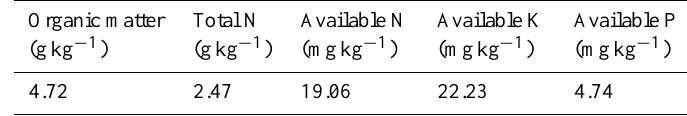
Table 1. Some chemical properties of the local soil used in the field experiment. Organic matter Total N Available N Available K Available